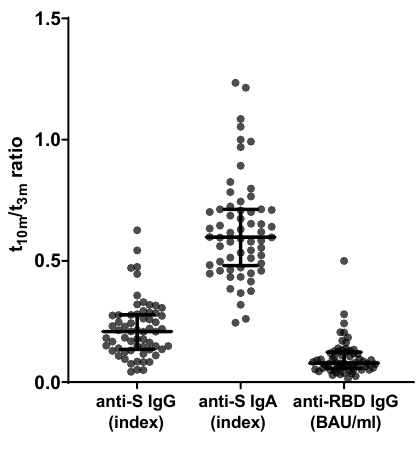
Figure 2. Evolution of SARS-CoV-2-specific serology between mid- and long-term follow-up ( n = 62). From left to right: anti-S IgG ratio, anti-S IgA ratio and anti-RBD IgG ratio between t 10m and t 3m . Error bars represent median with IQR. Abbreviations: S = spike, RBD = receptor-binding domain, pre = baseline sampling moment before vaccination, 3m = 3 months after baseline, 10m = 10 months after baseline, IQR = interquartile range. Table 1. Correlation of SARS-CoV-2-specific humoral parameters measured after BNT162b2 vac- cination.